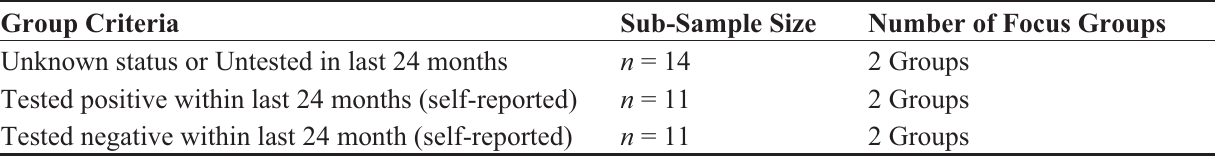
Table 1. Characteristics of participants by focus group assignment (N =